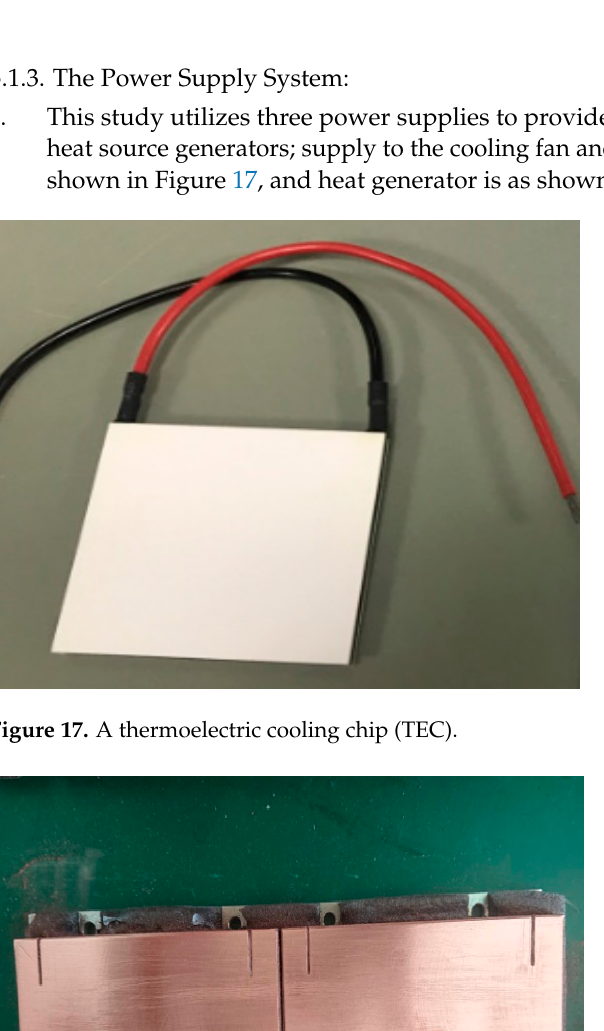
Figure 19. A heat dissipation system. 5.2. Discussion This study conducted experiments to verify type I and II passive heat dissipation systems from simulation results to determine whether their temperature distribution trend was identical and to confirm the cooling performance of the designed types of heat dissipation system. However, under conditions of passive heat dissipation, temperature control could not achieve the –20 °C~+70 °C temperature range required by standard elec- tronic components. This study maintained a stable-state temperature above 70 °C in both simulation and test results, so an active cooling system was required. This study also uti- lized TECs to quickly absorb heat and used cooling fins and fans to transfer heat outside the system. Hopefully, the test verifies the heat dissipation performance of types I and II